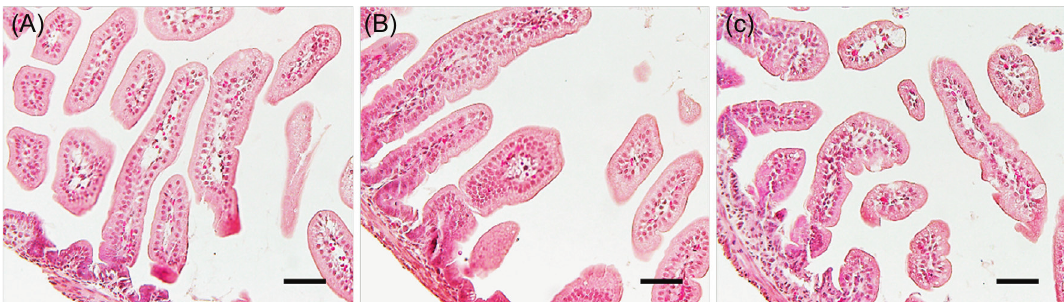
Figure 5. Representative figures of the small intestines of suckling mice inoculated at 24 h post-infection with phosphate-buffered saline (A), K. septempunctata at 5 · 10 6 spores/mouse (B) and K. septempunctata at 5 · 10 7 spores/mouse (C). A–C: Haematoxylin and eosin staining. Scale bars = 50 l m.